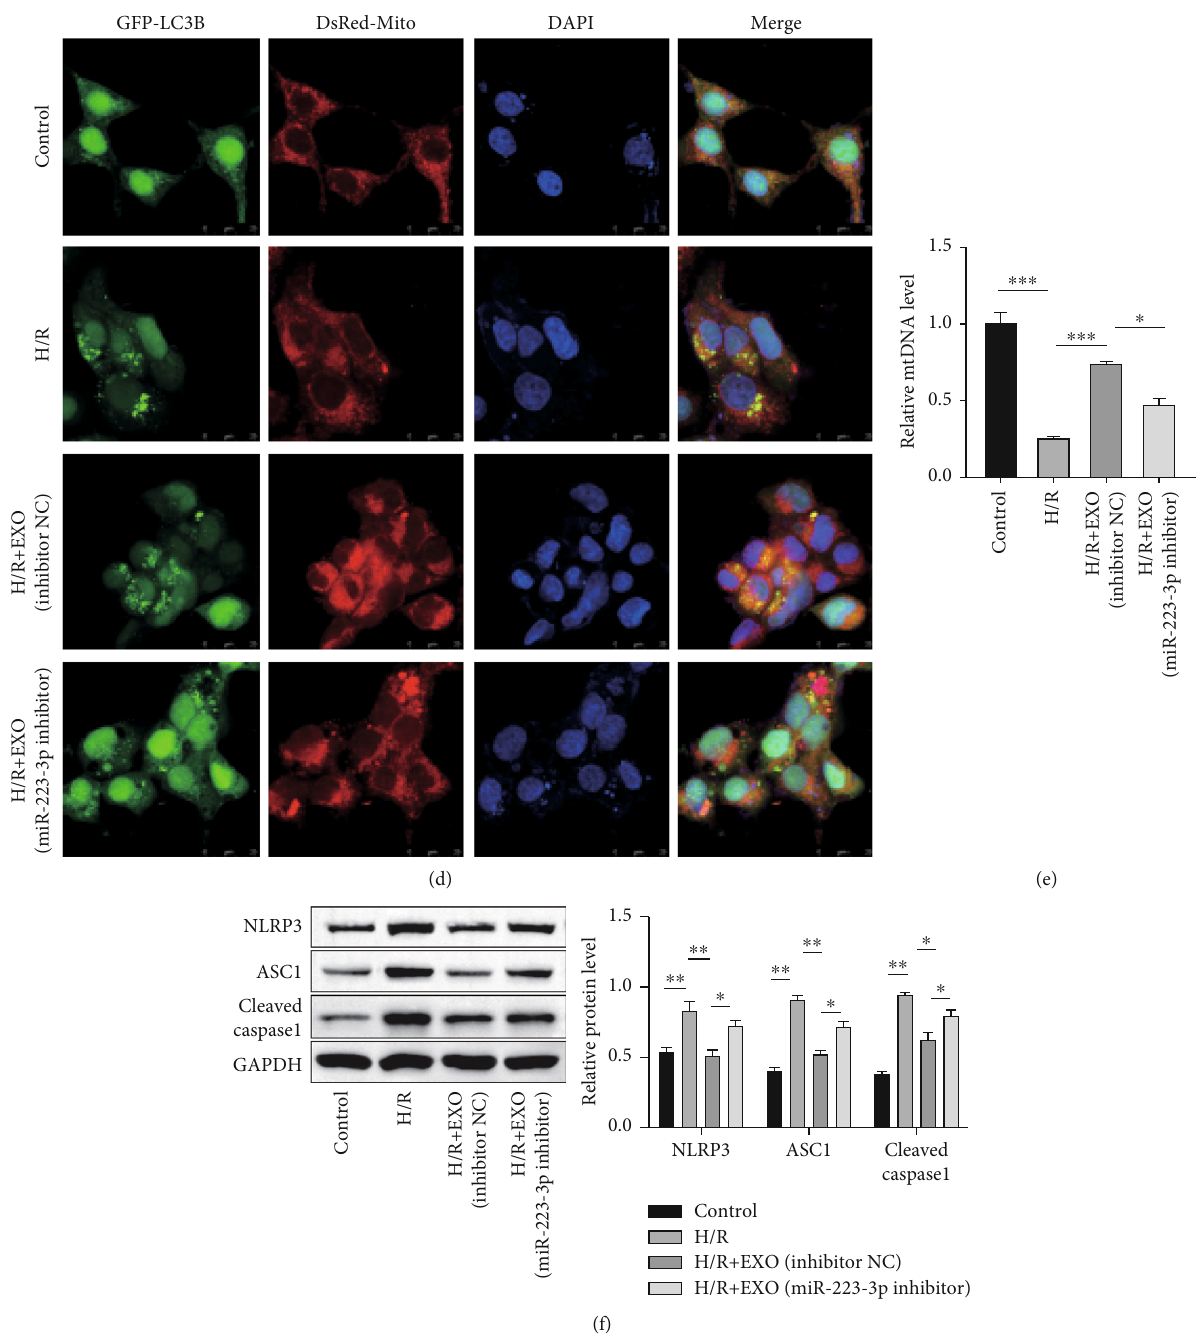
Figure 5: Exosome-delivered miR-223-3p mediated the protective e ff ect of EVs in H/R-stimulated TCMK-1 cells. TCMK-1 cells were subjected to H/R stimulation and miR-223-3p-depleted exosome treatment. (a) The H/R-induced cell apoptosis was determined using fl ow cytometry. (b) The protein levels of BAX, cleaved caspase-3, and Bcl-2 were con fi rmed by performing the western blot analysis. (c) Expressions of the mitophagy markers were detected using the western blot analysis. (d) Mitophagosome formation was assessed based on the colocalization of the autophagy marker GFP-LC3B and the mitochondria marker Mito Tracker (DsRed-Mito). (e) The levels of mitochondrial DNA (mtDNA) were determined through qPCR. (f) The expressions of NLRP3, ASC1, and cleaved caspase 1 were evaluated using the western blot analysis. N = 3 . ∗ P < 0 : 05 ; ∗∗ P < 0 : 01 ; ∗∗∗ P < 0 : 001